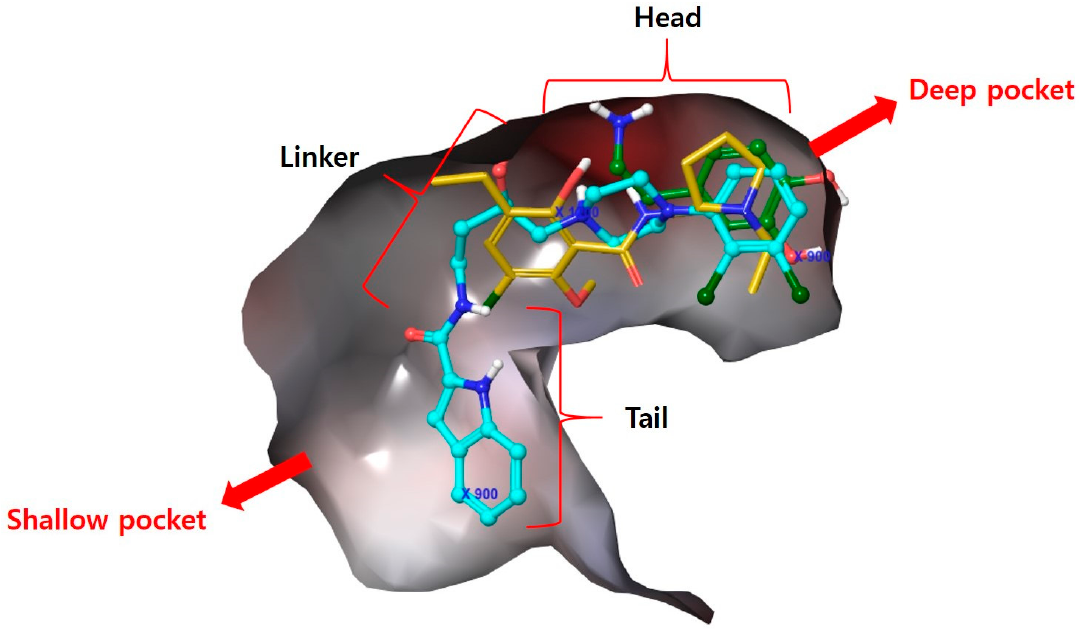
Figure 1. Superimposed 3PBL protein-ligand docking of dopamine (green; endogenous D3R agonist), eticlopride (yellow; non-selective D3R antagonist) and R-22 (sky blue; selective D3R antagonist).